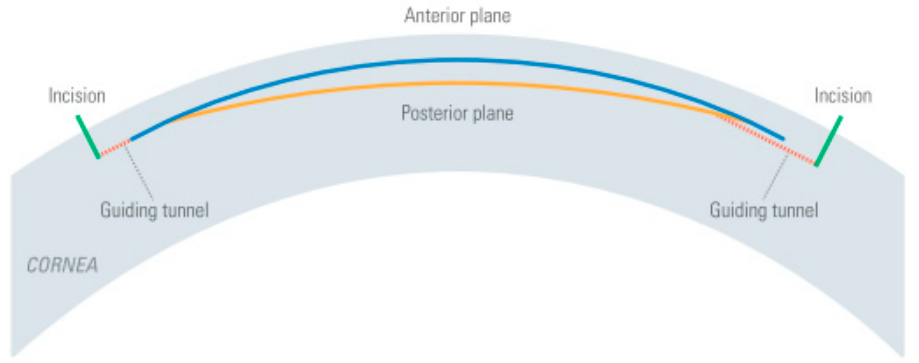
Figure 11. Schematic view of intrastromal lenticule cuts performed by an fs laser. The lenticule created between the anterior (blue) and posterior (yellow line) cut planes is extracted by the surgeon via an incision (green line). Optionally there is a second incision created to help mobilize the lenticule.